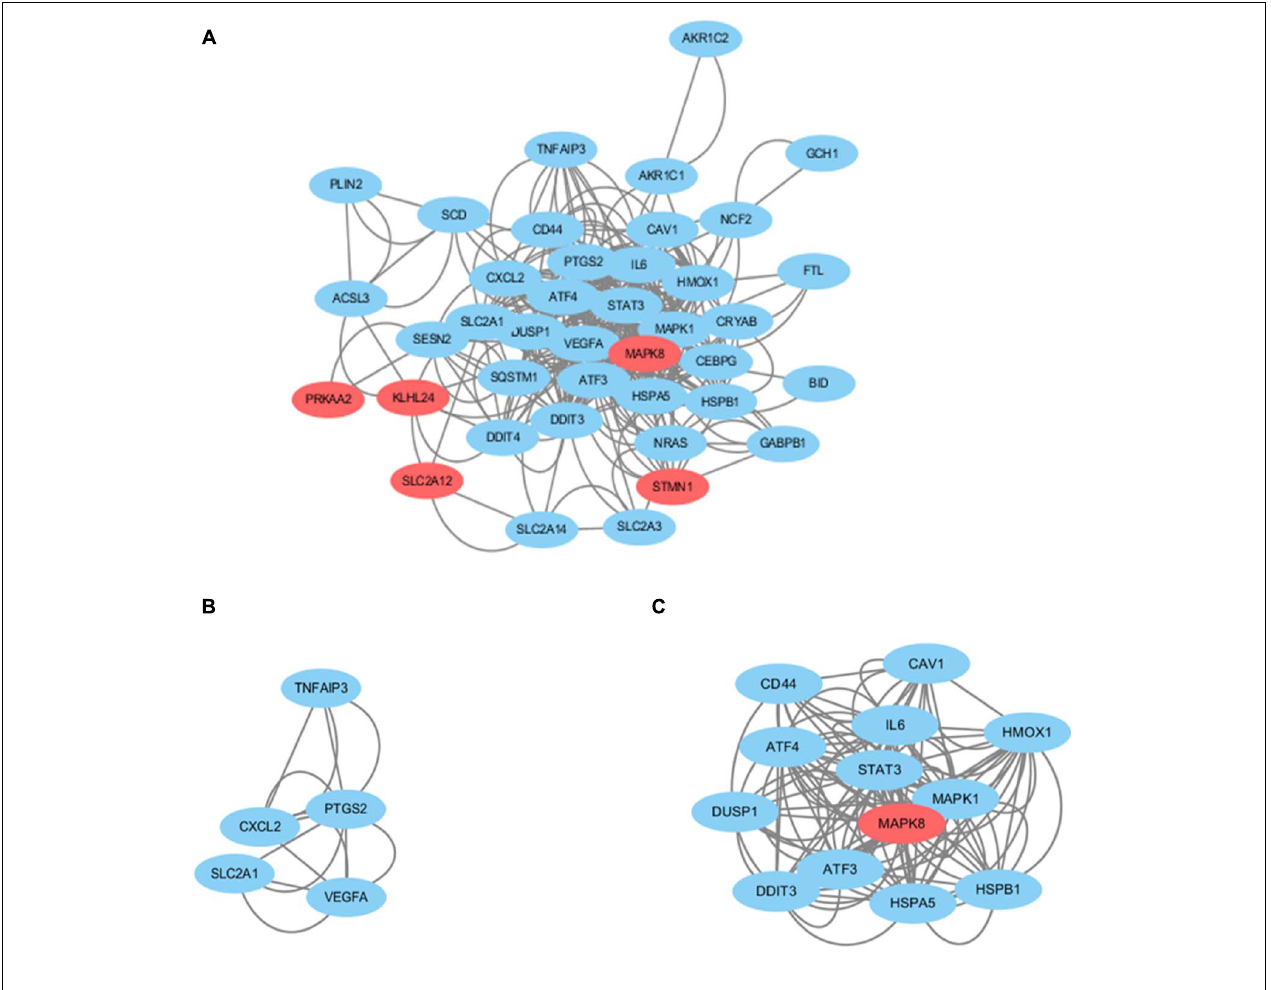
FIGURE 5 | (A) Cytoscape network visualization of the 40 nodes and 330 edges that were obtained with interaction scores > 0.4 according to the STRING online database. The nodes represent genes and the edges represent links between genes. Red represents downregulated genes, and blue represents upregulated genes. Two key modules were identified by MCODE, which was used to identify network gene clustering. (B) Cluster 2. (C) Cluster 1.